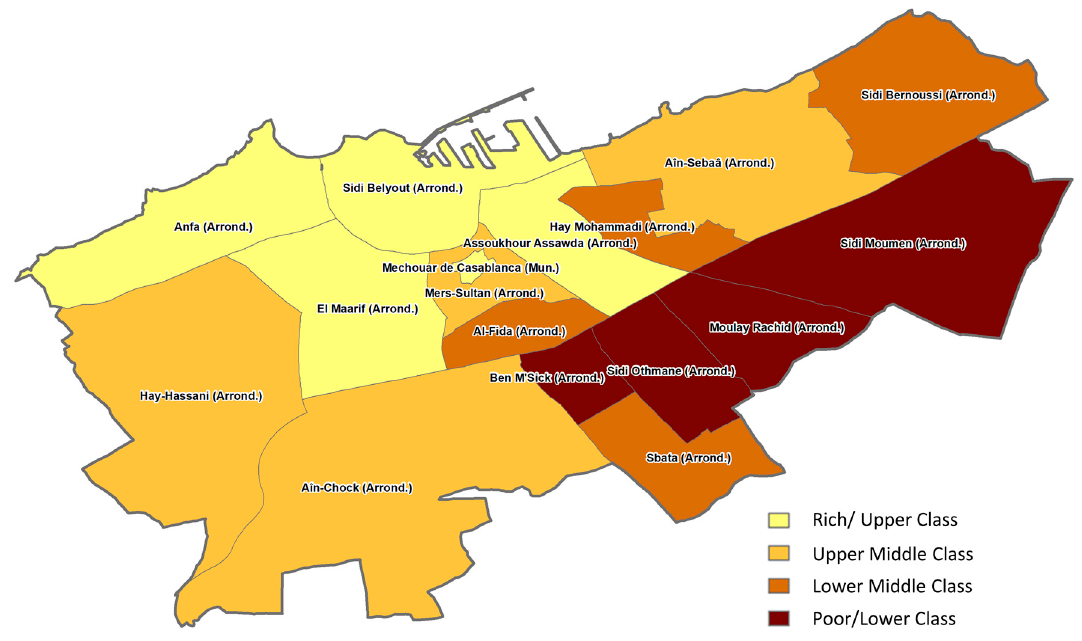
Figure 9. The main geographic location of the social class in Casablanca.